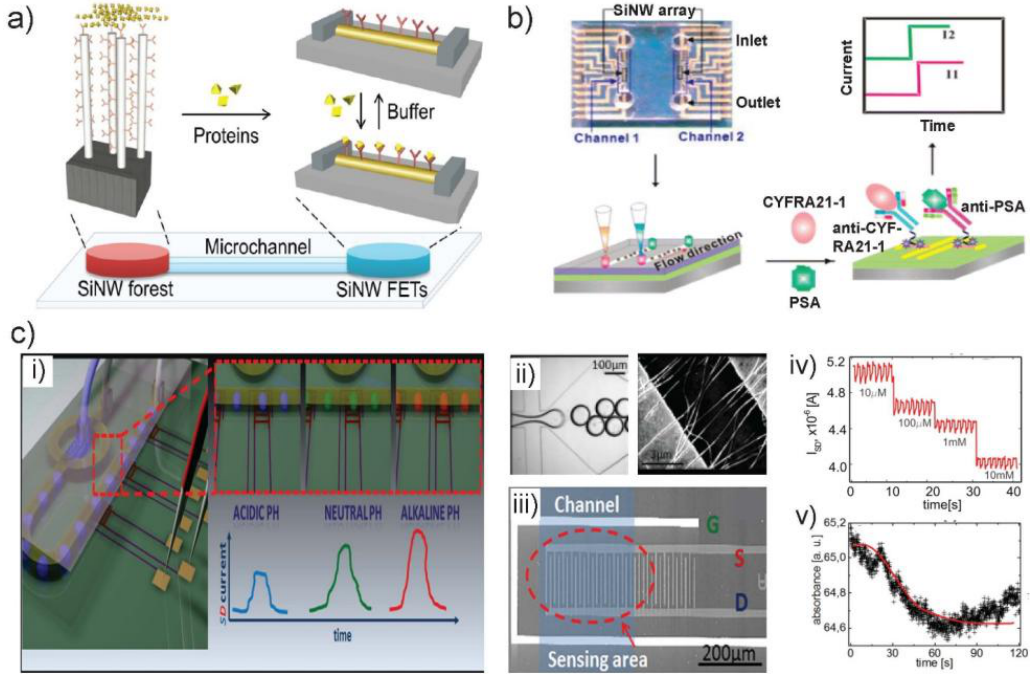
Figure 6. ( a ) Scheme of the operation of a whole-SiNW selective filtering and sensing device on a single chip platform. ( b ) Image of PDMS microfluidic system superimposed on SiNW arrays for fluid exchange (left top). Scheme of flowing antigens through the PDMS microchannel (left bottom); rapid recognition of cytokeratin 19 fragment (CYFRA21-1) and prostate specific antigen (PSA) using microfluidic integrated SiNW biosensor (right bottom) and real-time current readout (right top). ( c ) Compact NW sensors probe microdroplets. ( i ) Concept illustration of the integration of a SiNW FET into a droplet microfluidic system. Droplets with different pH will give rise to a different conductance change. ( ii ) Multiphase microfluidics, in which two immiscible liquids are combined to create identical isolated droplets (left) and SEM picture of the SiNW connecting source and drain electrodes. ( iii ) Top view of a single ion-sensitive field effect transistors (ISFET), showing source (S), drain (D), and the Ag/AgCl reference electrode (G) on silicon wafer. ( iv ) Raw current signal showing the decrease with increasing concentrations of PBS. ( v ) The changes in absorbance signal during GOx enzymatic oxidation of glucose confirmed the parallel readout of the reaction droplets using integrated optical detection setup. Images in ( a ) are reproduced with permission from [69], ( b ) from [70] and ( c ) from [71].